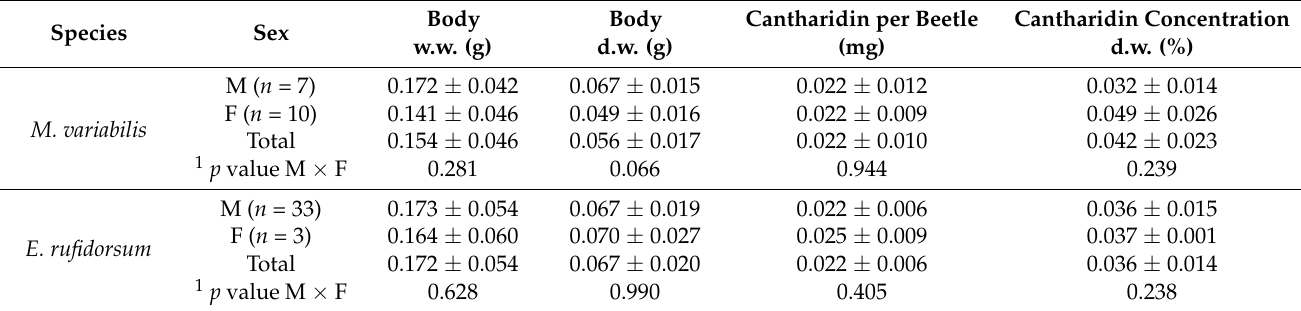
Table 2. Body weight and cantharidin concentration in Mylabris variabilis and Epicauta rufidorsum. Body Body Cantharidin per Beetle Cantharidin Concentration Species Sex w.w. (g) d.w. (g) (mg) d.w. (%) M ( n = 7) 0.172 ± 0.042 0.067 ± M. variabilis